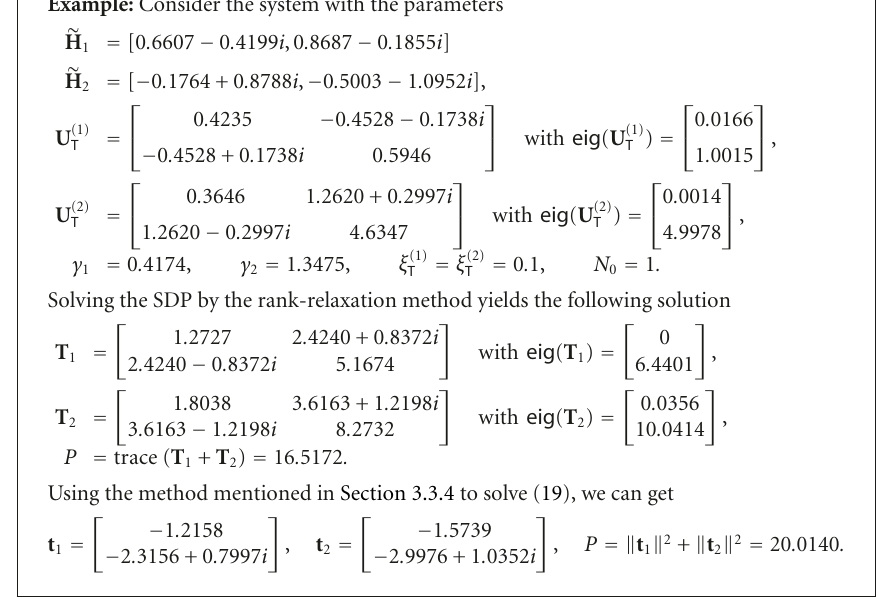
Figure 1: A numerical example showing how the countermeasure